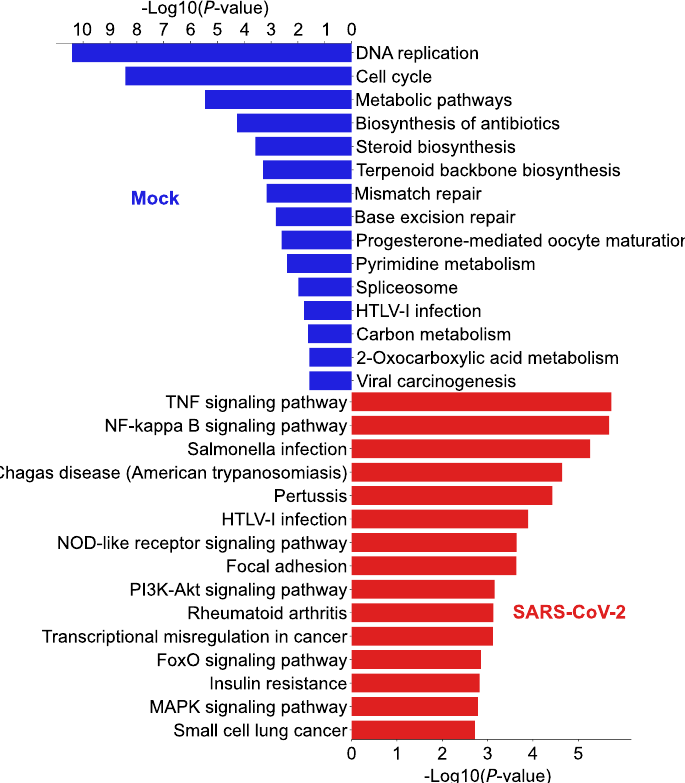
Figure 7. Differentially expressed transcripts enriched KEGG pathways. The blue and red bar charts show the pathways enriched by the up-regulated and down-regulated transcripts in mock-treated samples over SARS-CoV-2 infected samples,